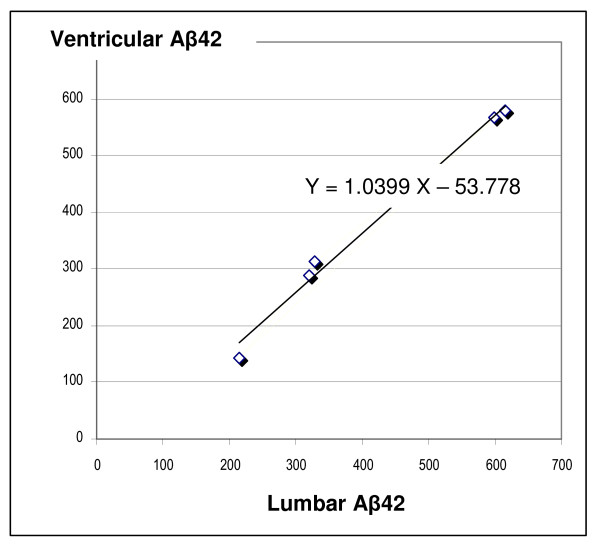
Correlation between lumbar and ventricular CSF levels of Aβ42 (values are expressed in pg/ml; R2 = 0.989, P < 0.0001).